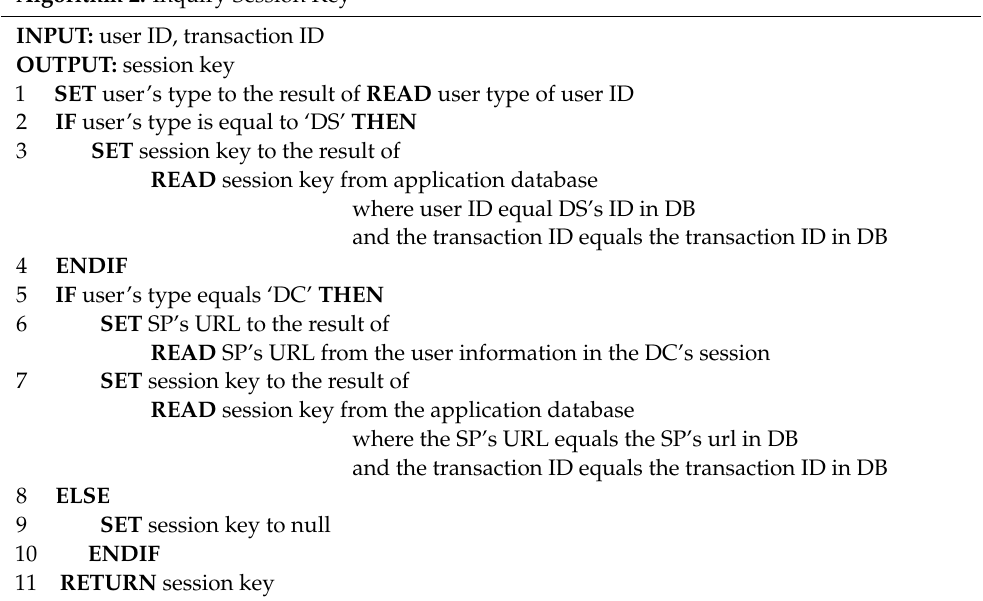
Algorithm 2. Inquiry Session Key